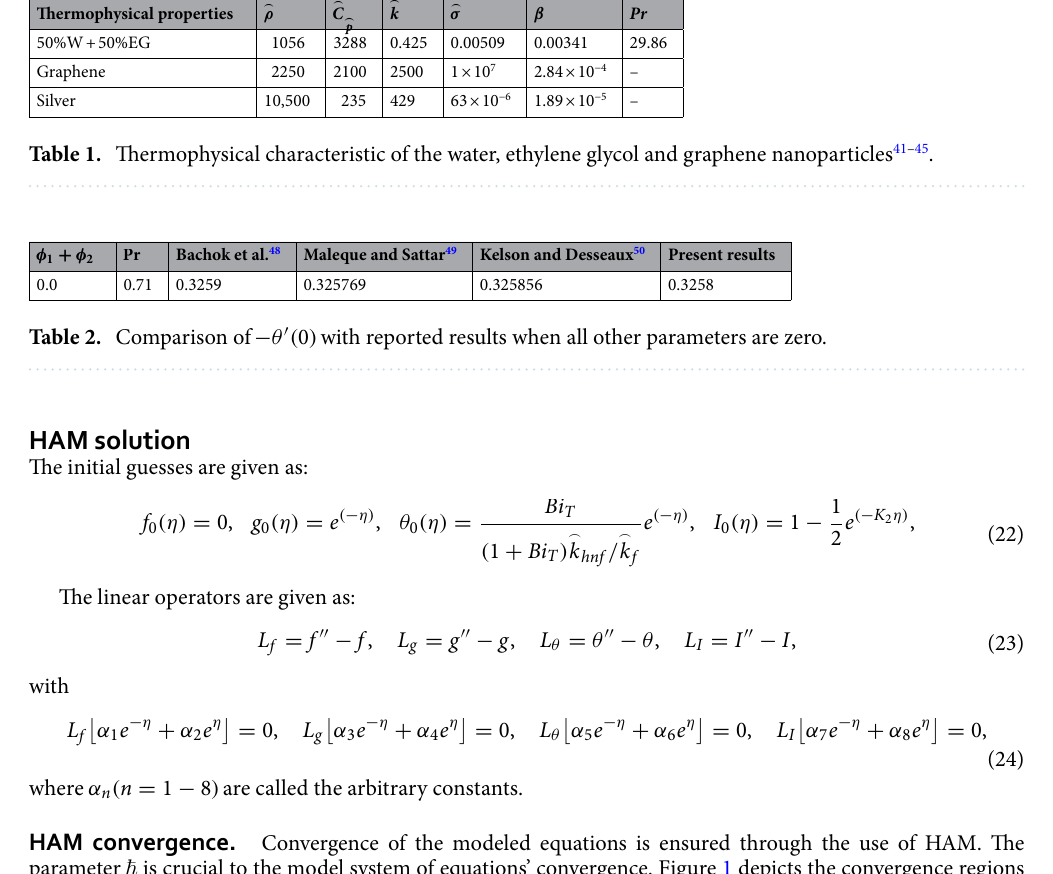
− 2.2 ≤ (cid:31) θ ≤ 0.2 and